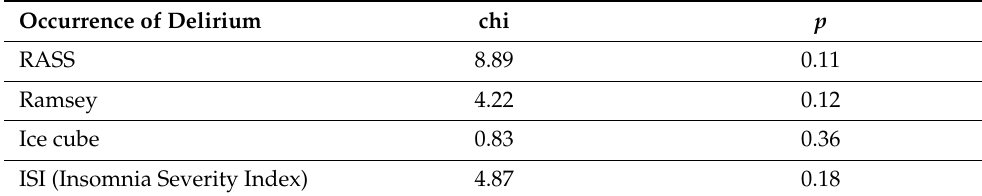
Table 8. Chi-squared test indicators and their statistical significance ( p